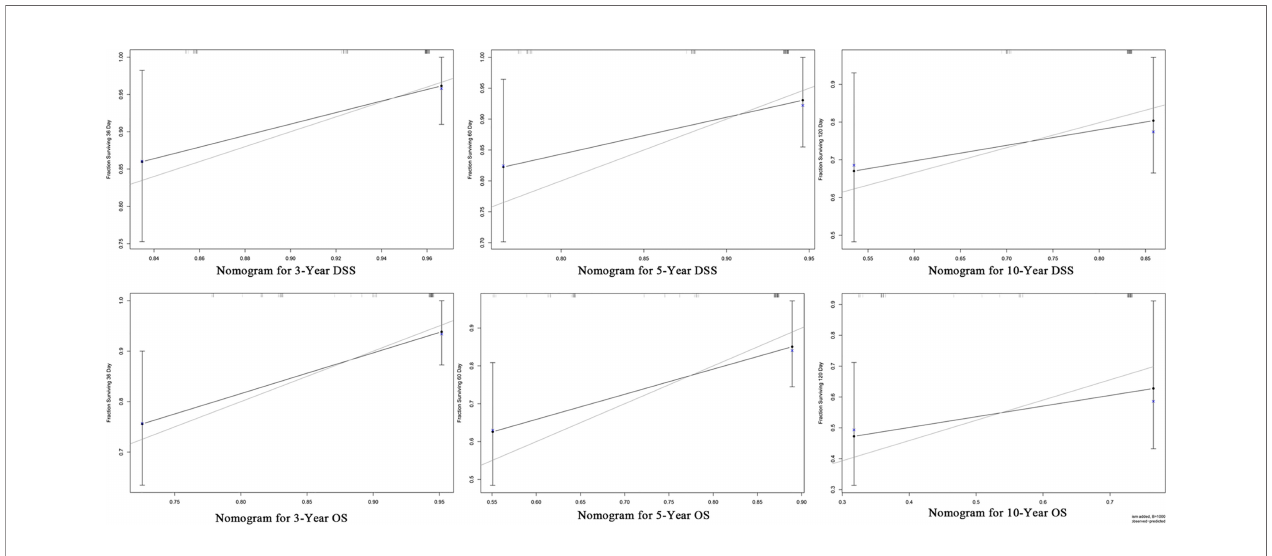
FIGURE 5 | Calibration curves for the 3-, 5-, and 10-year